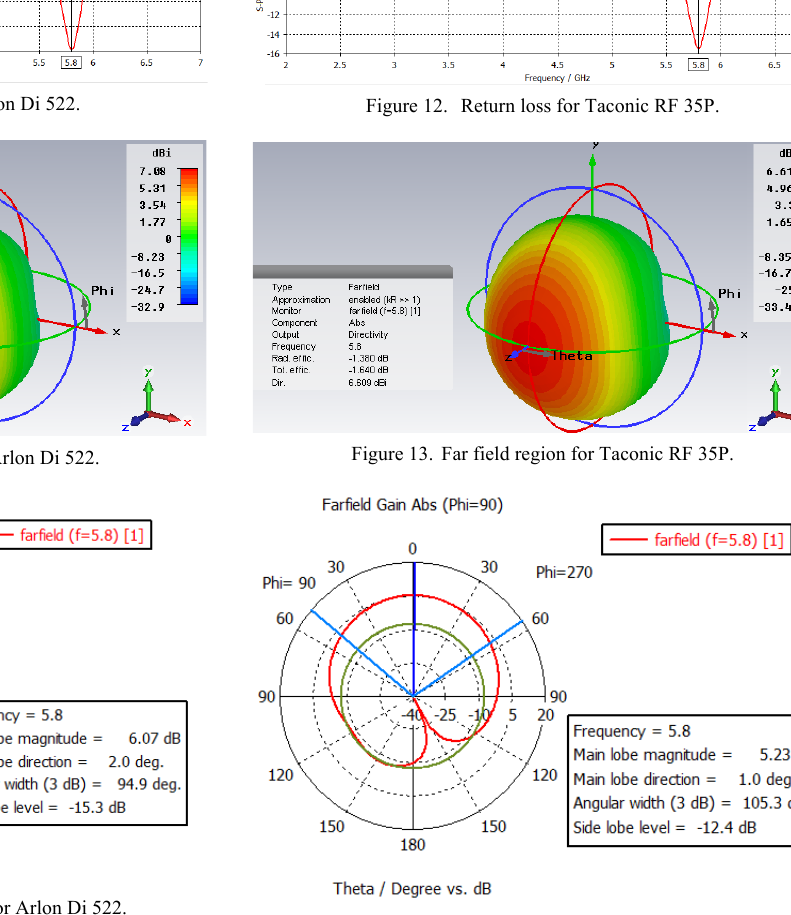
Figure 14. Far field in polar view for Taconic RF